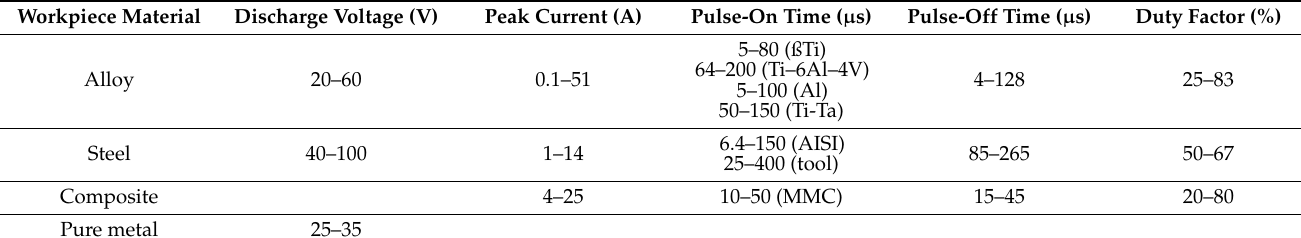
Table 19. Range of voltage, current, pulse-on and -off times and duty factor for various materials in EDC by PMEDM method [261].